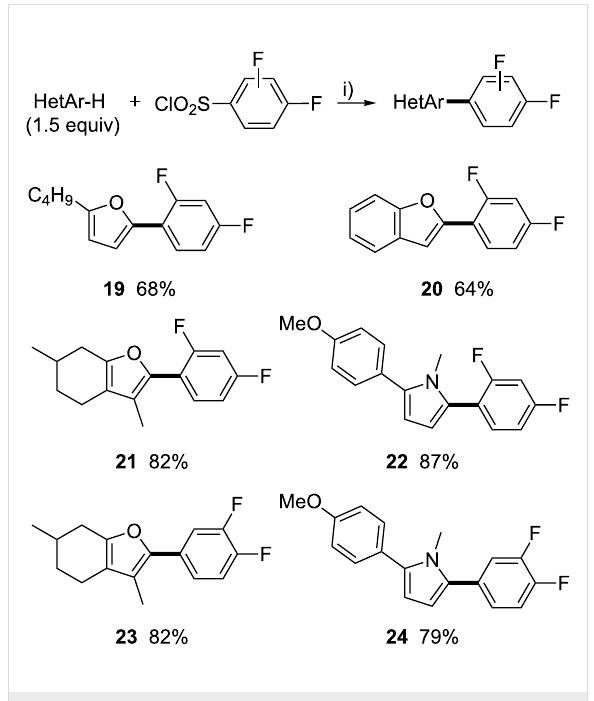
Scheme 5: Pd-catalyzed desulfitative direct arylations of heteroarenes using difluorobenzenesulfonyl chlorides as the arylating